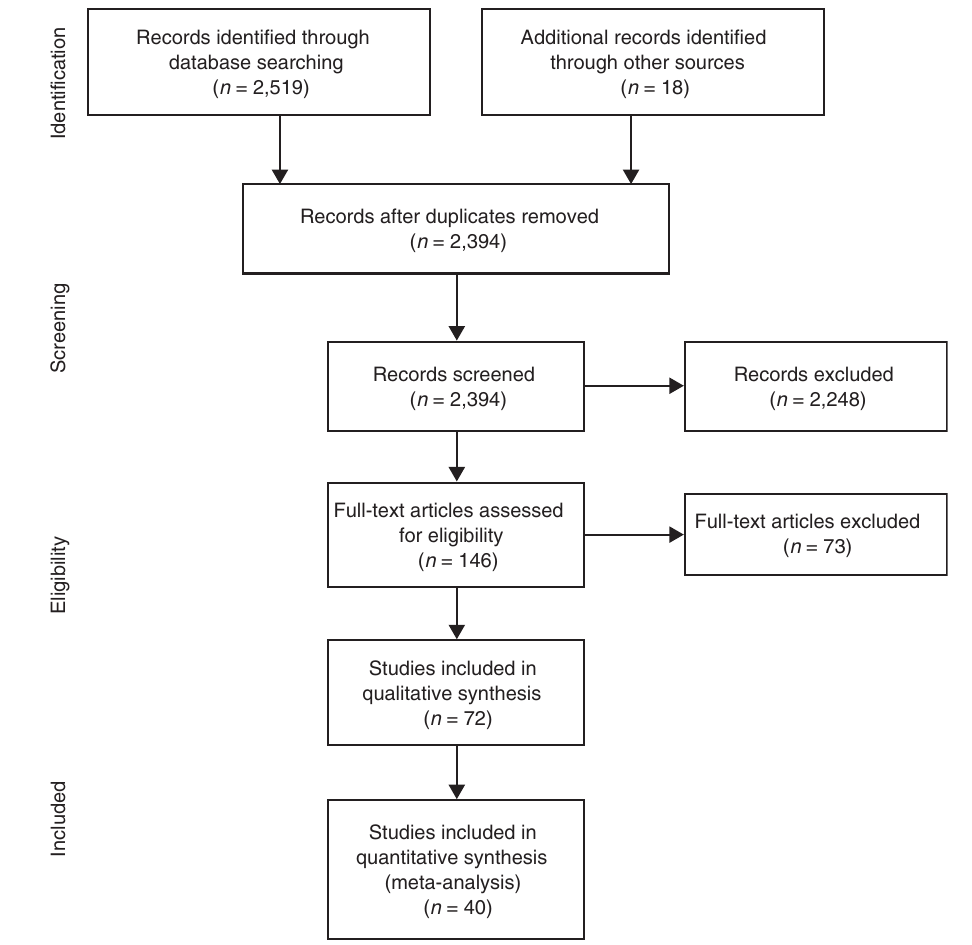
Fig. 1 PRISMA fl ow diagram describing the results of the systematic